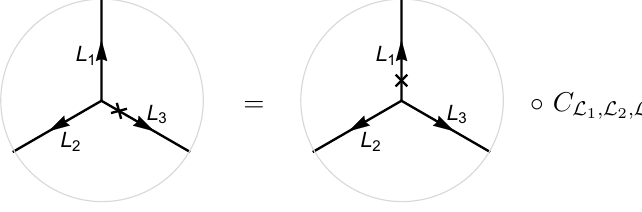
Figure 11 . The H-junction crossing kernel K L 1 ; L 4 of the Mercedes graph.